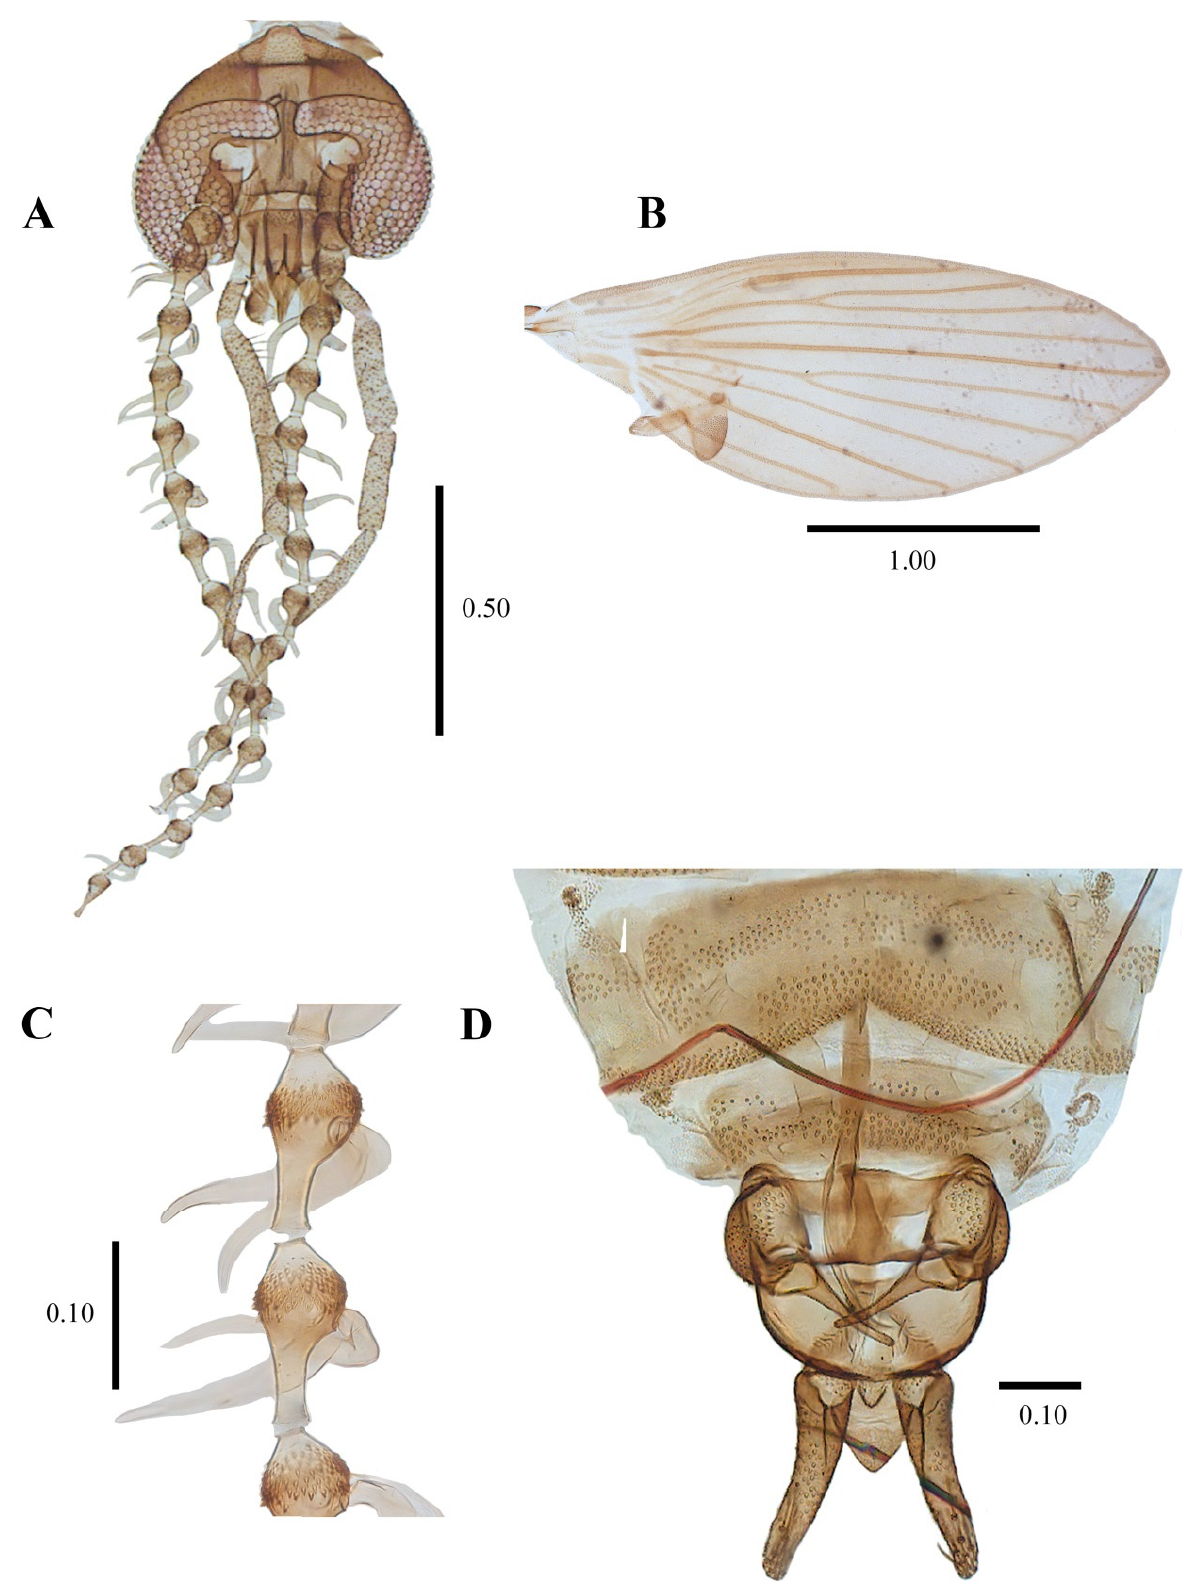
Figure 4. Lepiseodina latipennis (Sar à , 1953), male. ( A ) Head. ( B ) Wing. ( C ) Flagellomeres and ascoids. ( D ) Genitalia. Scale ( A – D ) in millimeters